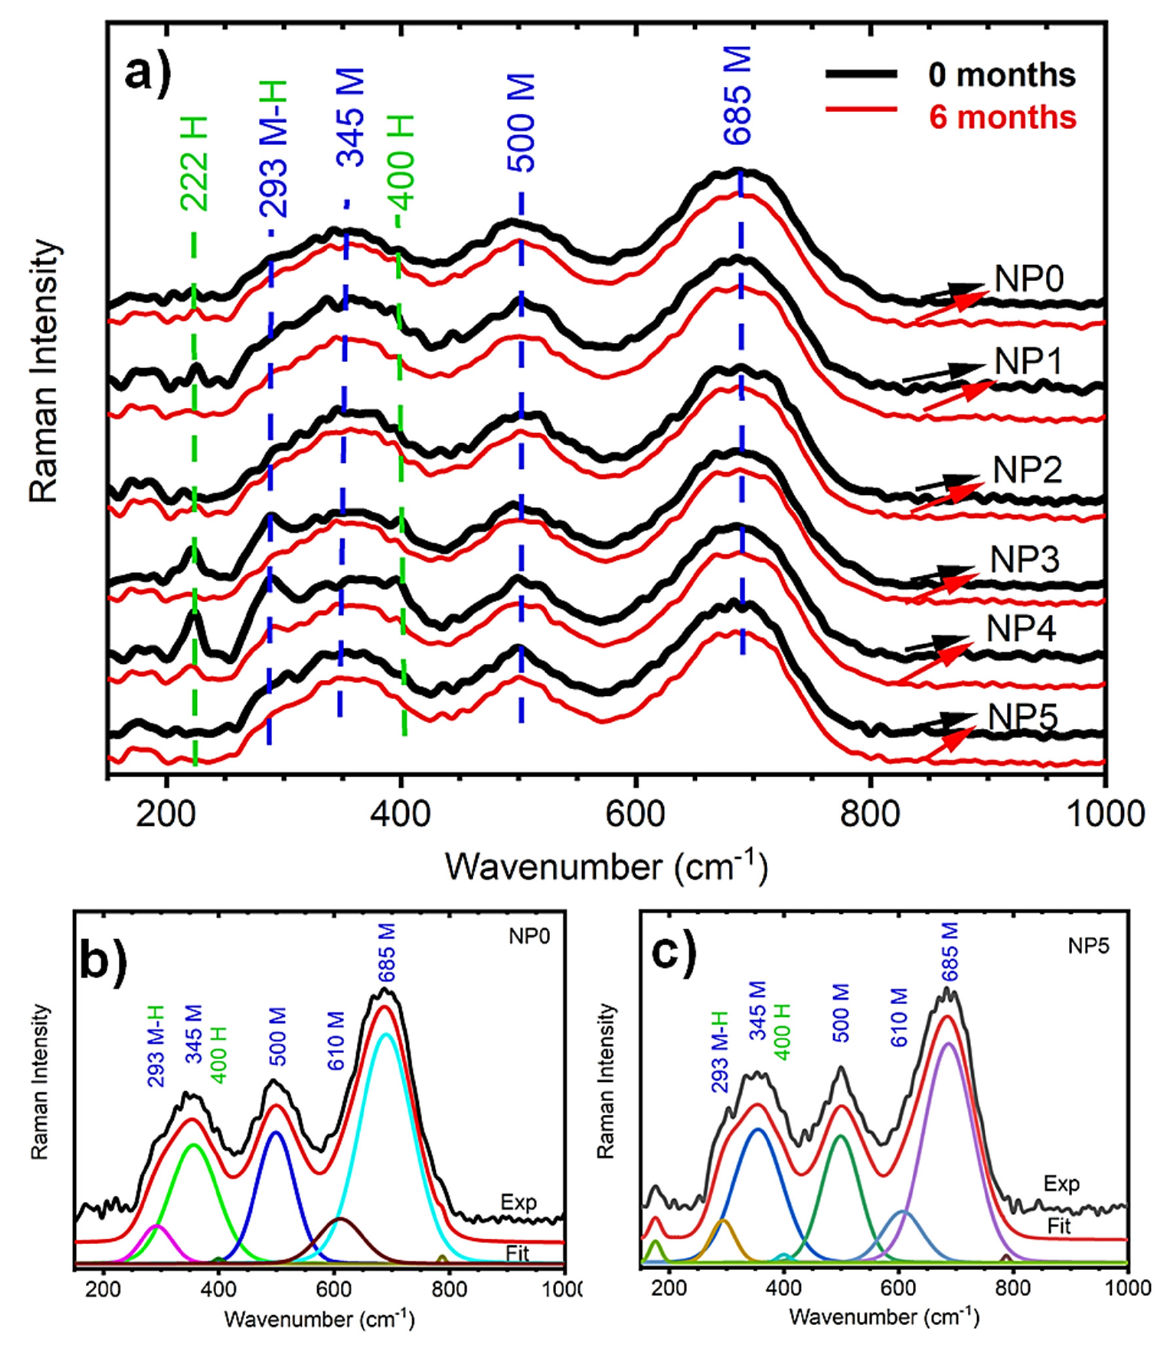
Figure 4. Raman measurements ( a ) taken at 0 and 6 months after synthesis for each sample obtained with a laser power of 20 mW, in which the spectral characteristic bands are predominant in the magnetite phase ( a ). Deconvolution of the Raman peaks for samples NP0 ( b ) and NP5 ( c ), in which we extracted the data for Table 5.